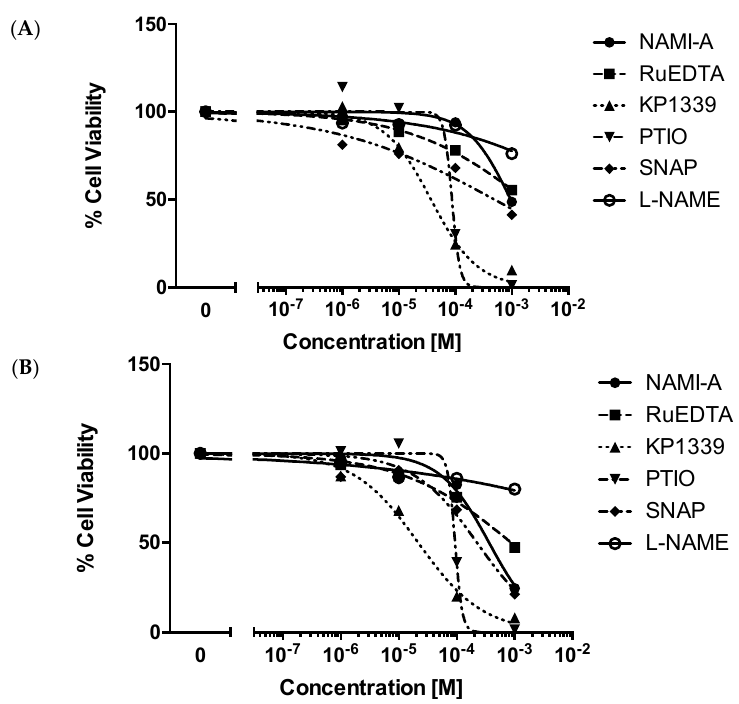
Figure 4. EA.hy926 cell viability after treatment with NAMI-A, RuEDTA, KP1339, PTIO, SNAP, and L -NAME. EA.hy926 cells were treated with compounds 10 − 6 –10 − 3 M for: 48 h ( A ); or 72 h ( B ). Cell viability was measured with the 3-(4,5-dimethylthiazol-2-yl)-2,5-diphenyltetrazolium bromide (MTT) test.